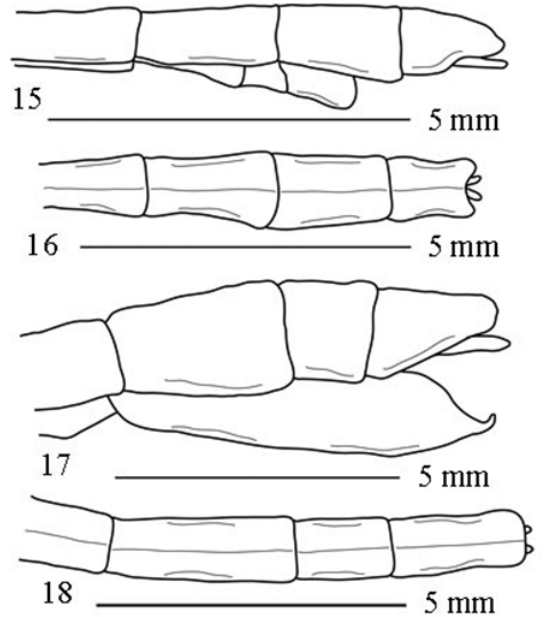
Figs 15–18. Parasinophasma liui sp. n. 15. ♂ , apex of abdomen, lateral view; 16. ♂ , apex of abdomen, dorsal view; 17. ♀ , apex of abdomen, lateral view; 18. ♀ , apex of abdomen, dorsal